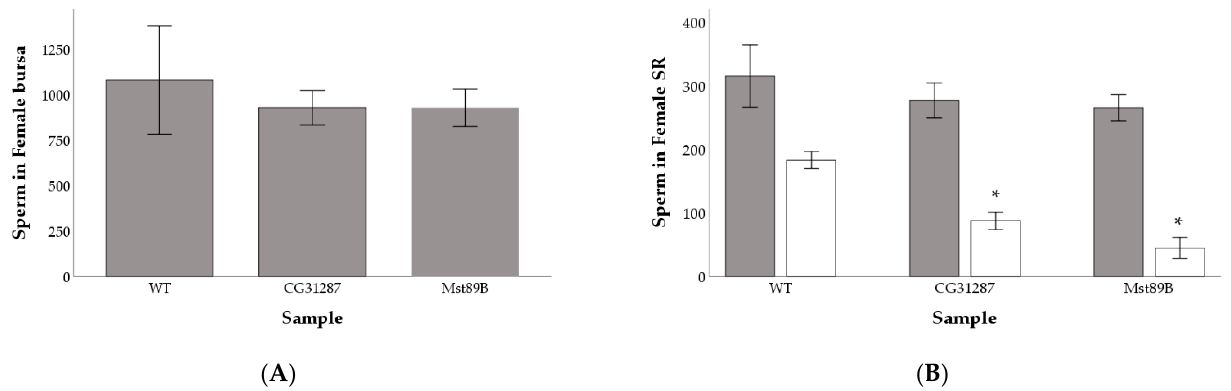
Figure 4. Average number of sperm cells in the female bursa 30 min after the end of copulation ( A ) and average number of sperm found in the female seminal receptacle (SR) at 30 min (grey bars) and 24 h (white bars) after mating ( B ). Asterisks (*) above bars denote significant differences between the samples and the wild-type control. Error bars are 2 standard errors of the mean.